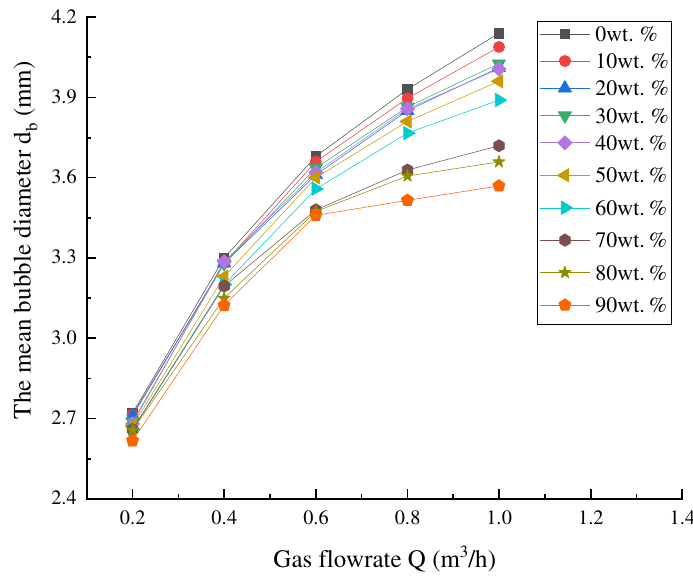
Figure 10. Effect of gas flow rate on the bubble size under the different proportions of fine sand. The bubble diameter of the nozzle with different composition ratios increases with the increase in gas flow. For the nozzle with a low proportion of fine sand, the bubble diameter is obviously affected. According to Equation (33), the bubble diameter is related to not only the gas flow but also the spreading at the bubble outlet.